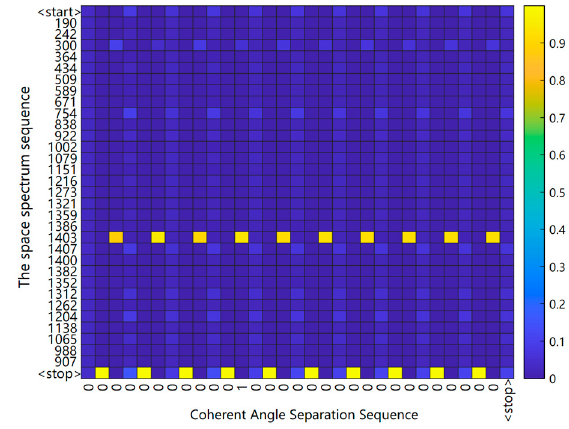
Figure 8. Heat map of attention.